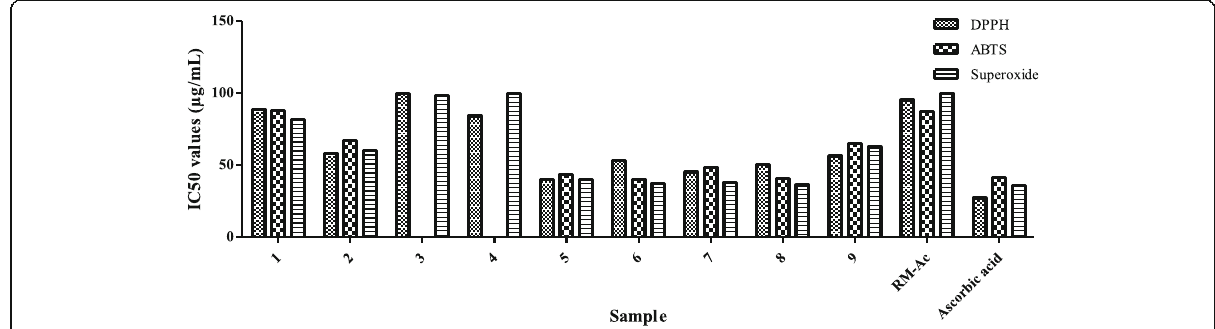
Fig. 2 IC 50 values of acetone extract and all compounds of Roccella montagnei against DPPH, ABTS and Superoxide free radicals